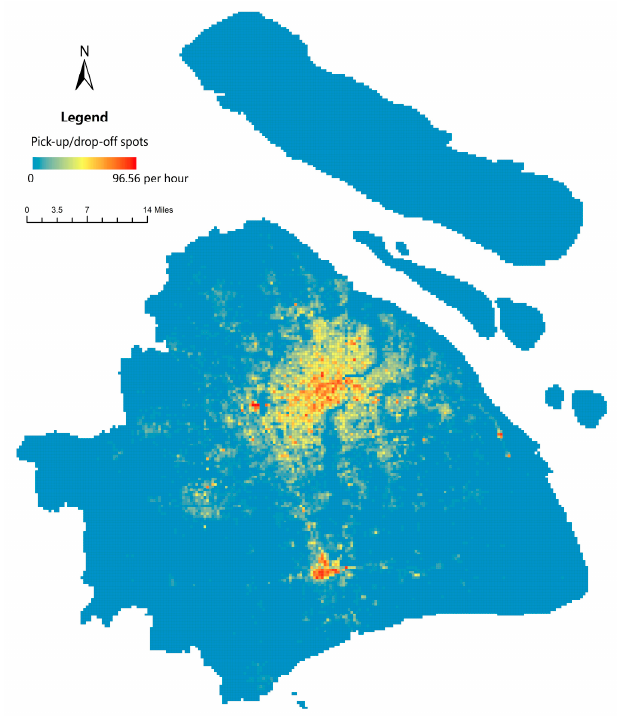
Figure 5. Grids and statistical results on